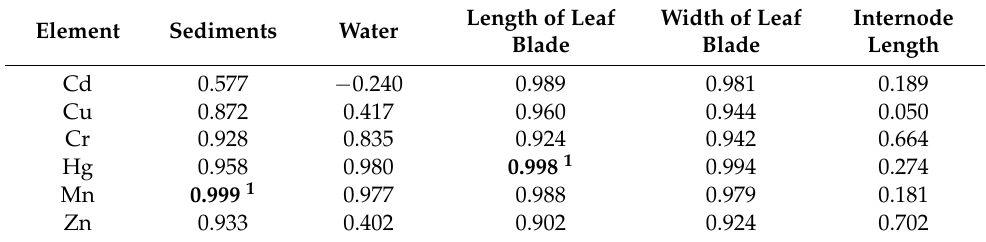
Table 6. Pearson linear correlation coefficient of G. densa shoot biometric